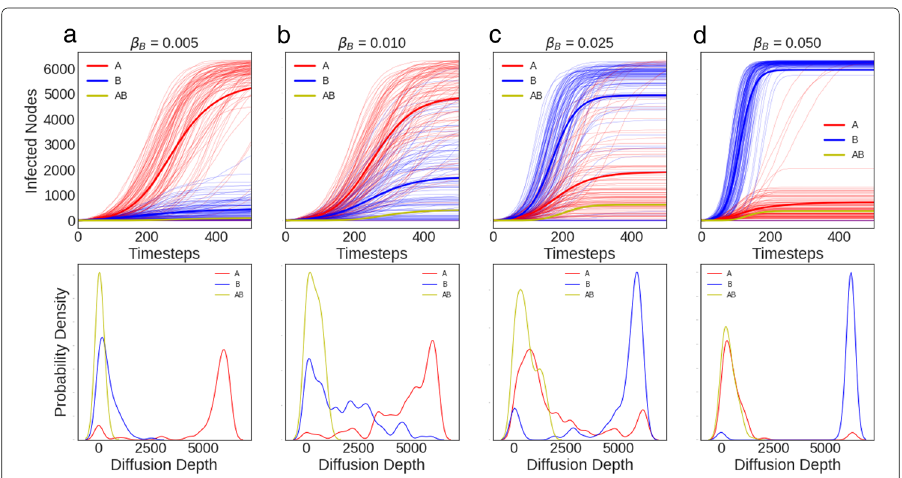
Fig. 4 Increasing β B with τ A = 0 and a low τ B = 0.02. When β B is low ( a ), Contagion B diffuses more slowly than A . However, as β B increases in ( b ), even when Contagion A still diffuses faster its diffusion depth has lowered. When β